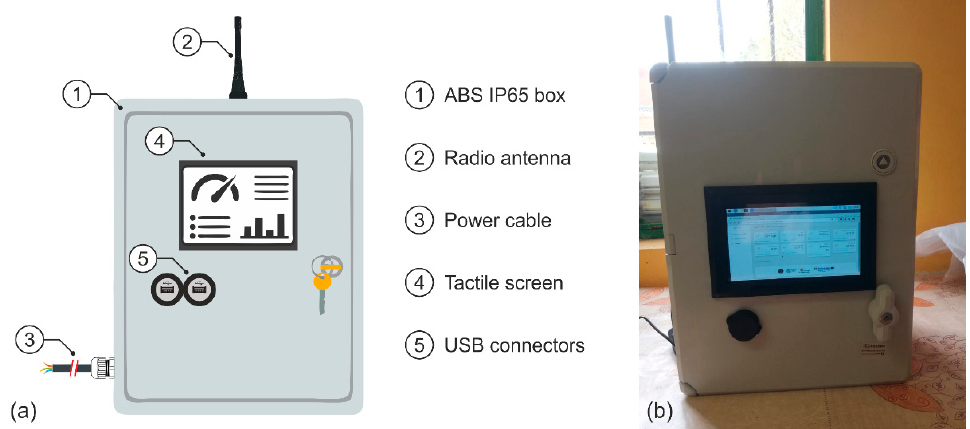
Figure 4. Gateway: ( a ) Initial sketch of the gateway; ( b ) Final design of the